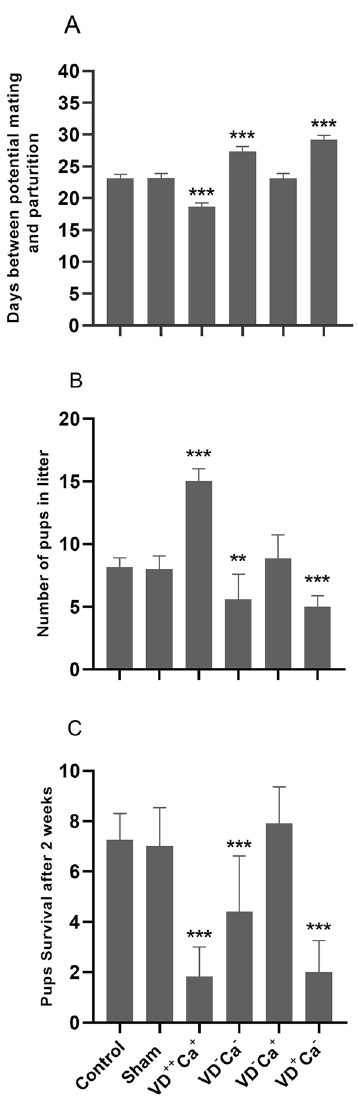
Figure 3. Effect of treatments on: ( A ) time from mating to parturition, ( B ) litter size and ( C ) survival rate. * p < 0.05, ** p < 0.001, and *** p <